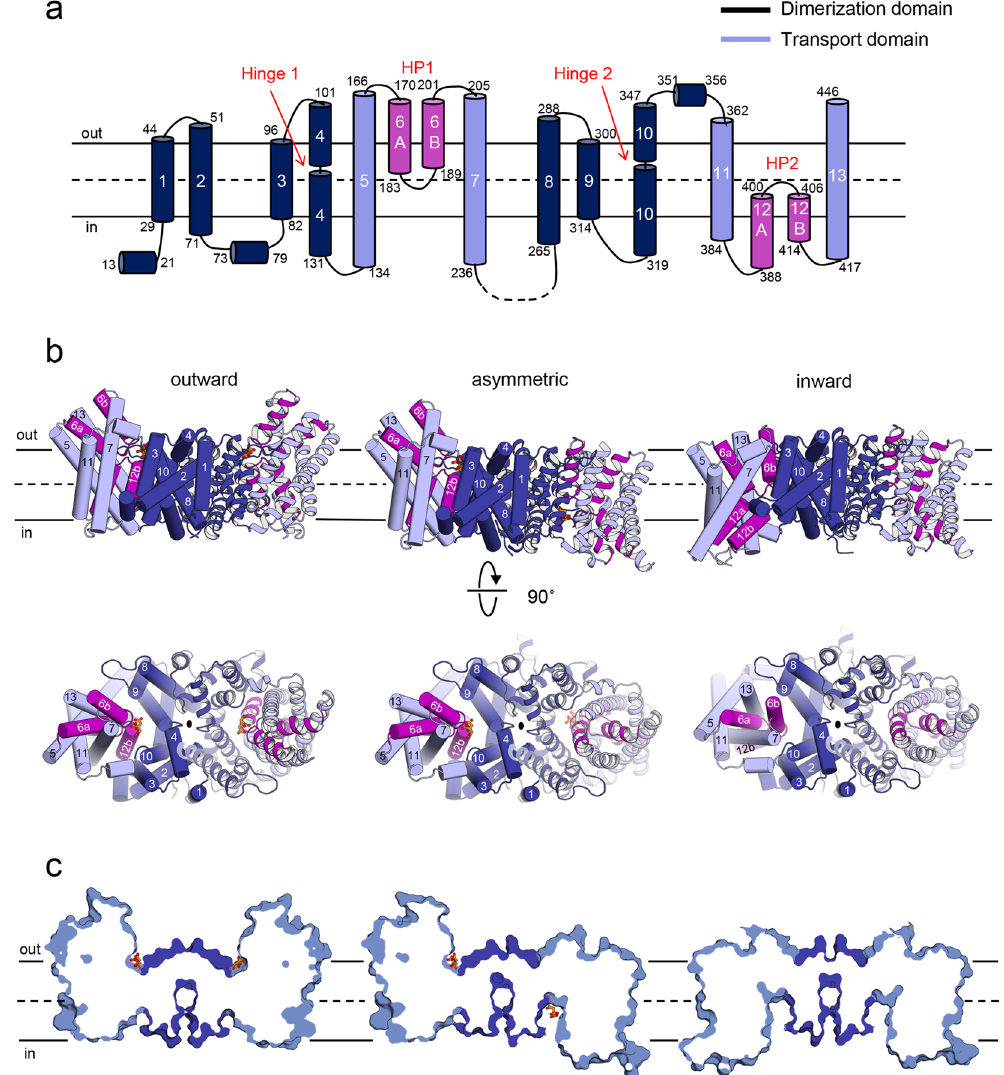
Figure 1. The three conformational states of the Kp CitS dimer. ( a ) Schematic representation of the Kp CitS protomer. The helices belonging to the dimerization and the transport domains are in dark and pale blue, respectively. Two helical hairpins of the transport domain are highlighted in purple. Residues in the loop connecting TM 7 and TM 8 are not included in the crystal structures due to their low electron density, and are drawn with a dashed line. Protein secondary structures were assigned using the STRIDE 53 . ( b ) The homodimeric Kp CitS structure in different functional states viewed from the membrane plane (top) and from the periplasm (bottom). Citrate is shown as an orange ball-and-stick model. The black oval is a pseudo 2-fold axis, perpendicular to the membrane. ( c ) Surface slab views of ( a